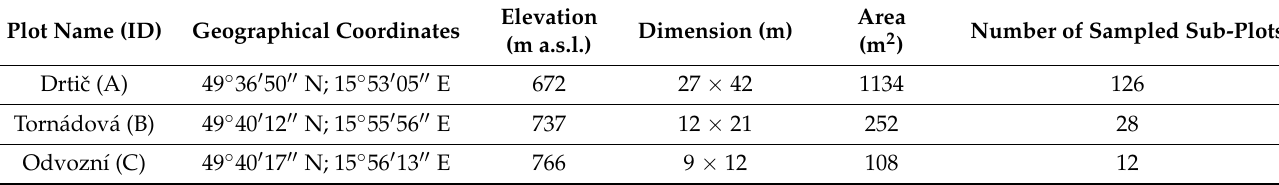
Table 1. Fundamental characteristics of the research plots.